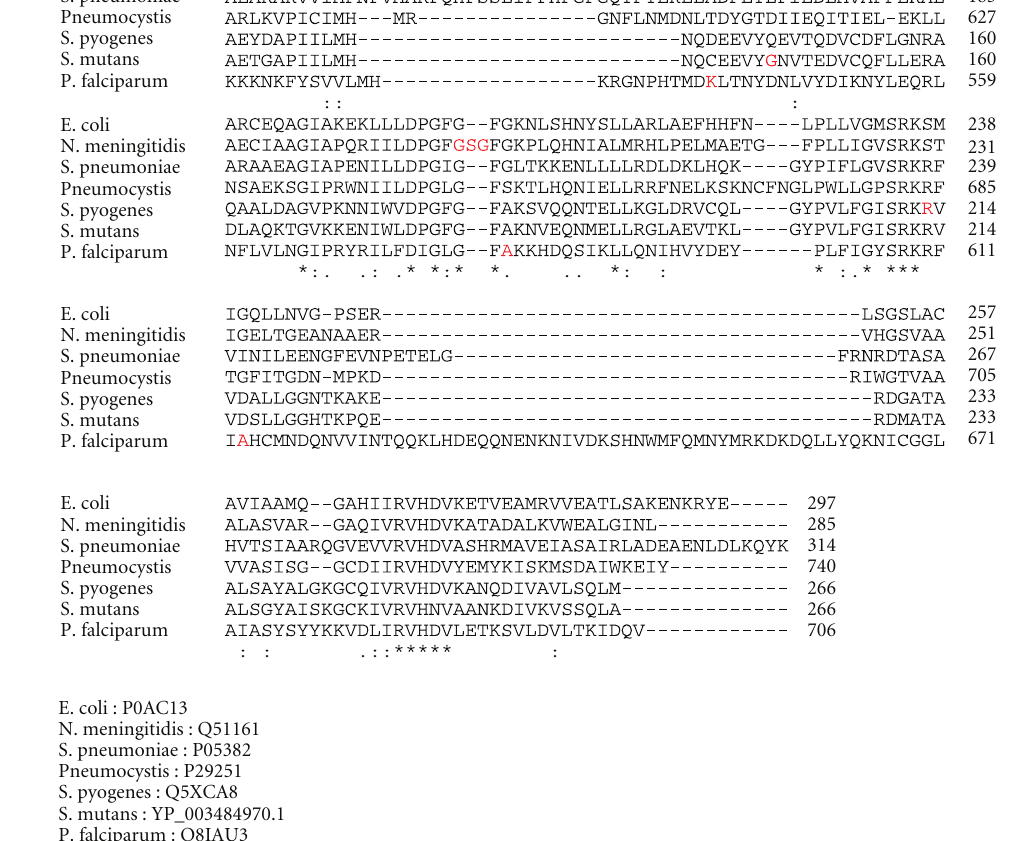
Figure 2: Comparison of the mutations in 797 compared to NN2025 showing that all di ff er quite substantially from positions where you find resistance determining mutations (in red) in other